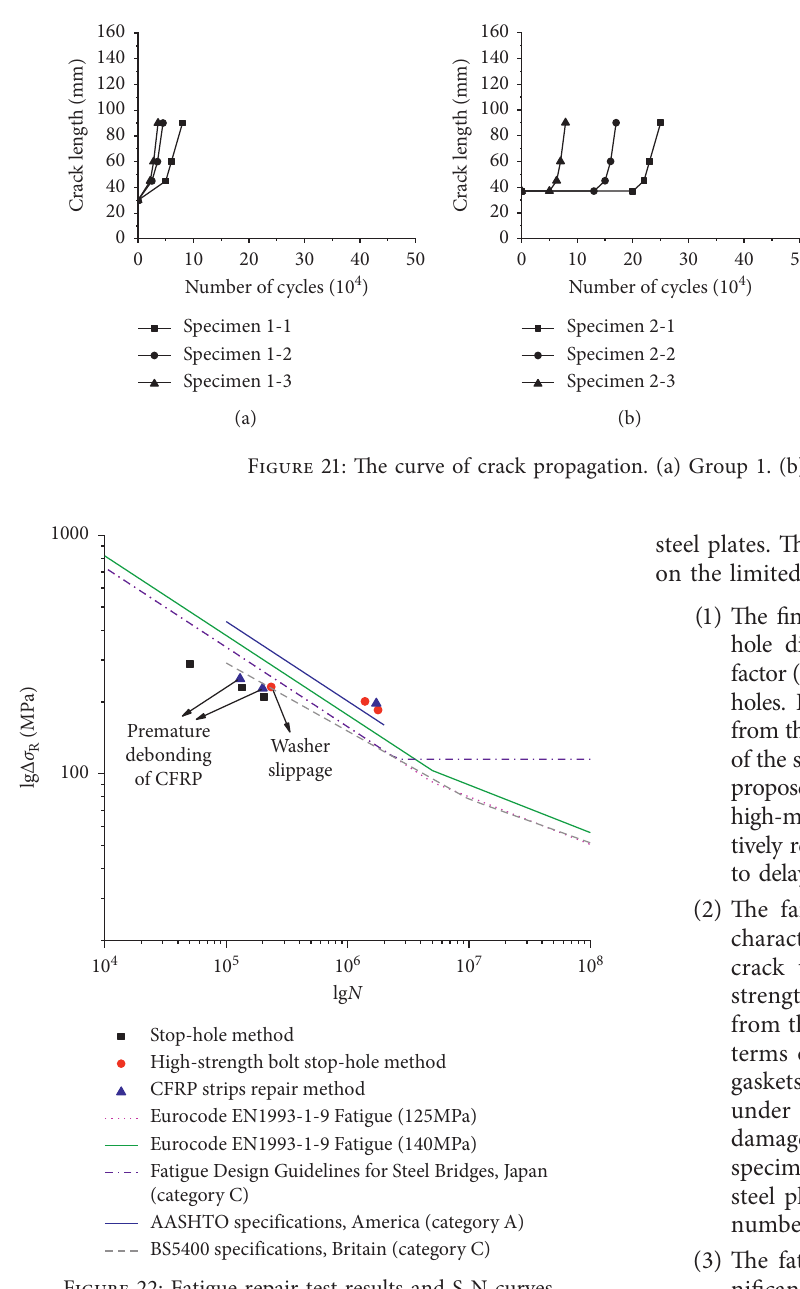
Figure 22: Fatigue repair test results and S-N